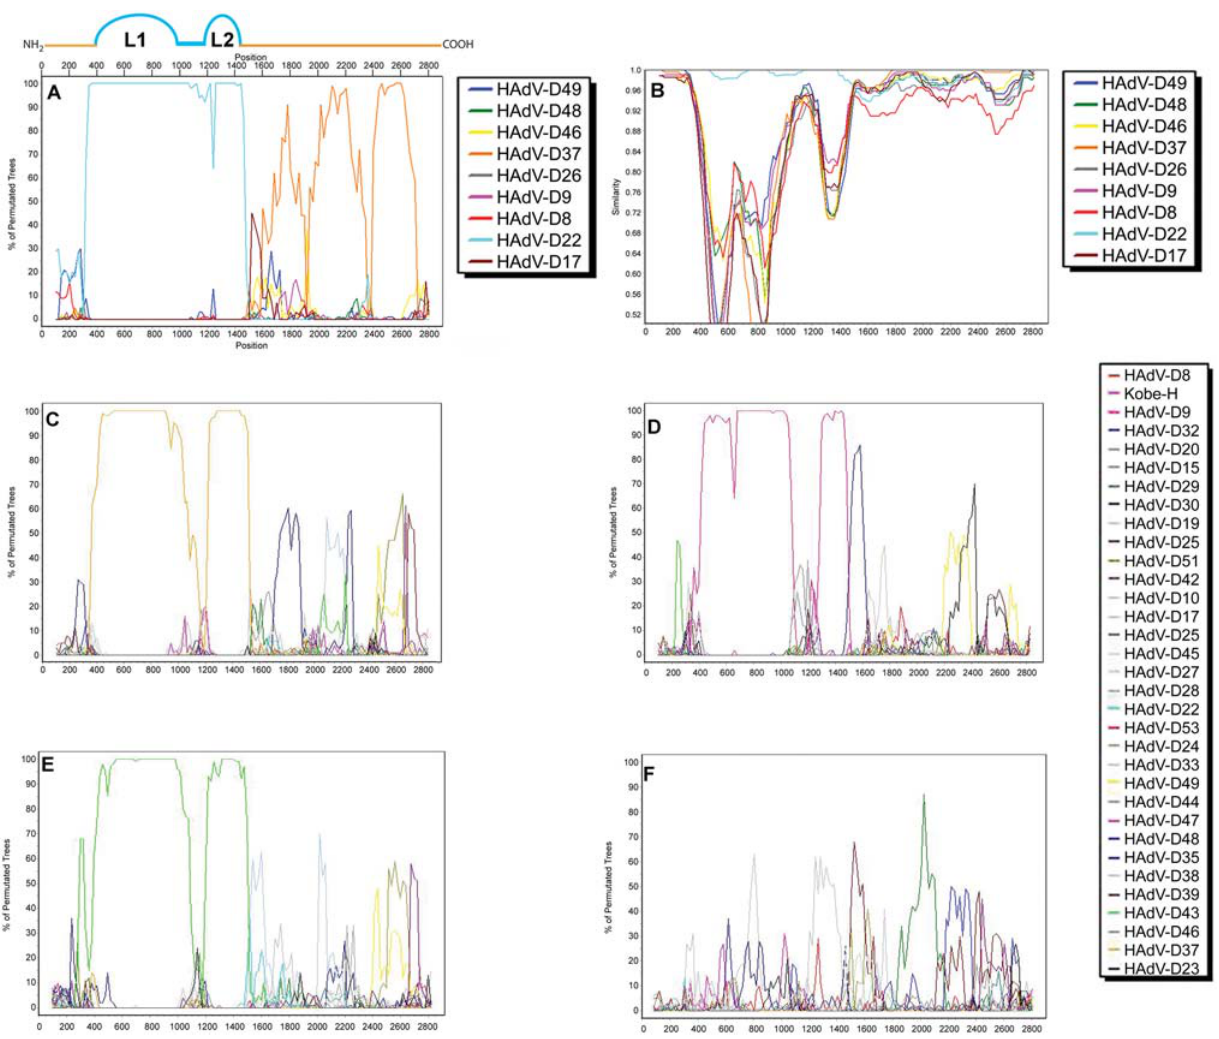
Figure 3. Bootscan of HAdV-D species hexon genes demonstrating recombination events. Comparison of HAdV-D53 by (A) bootscan and (B) simplot with the HAdV-D types which have a fully sequenced genome. (C) HAdV-D13, (D) HAdV-D32, (E) HAdV-D39, and (F) HAdV-D49 were compared to all hexon genes in species HAdV-D by bootscan analysis.